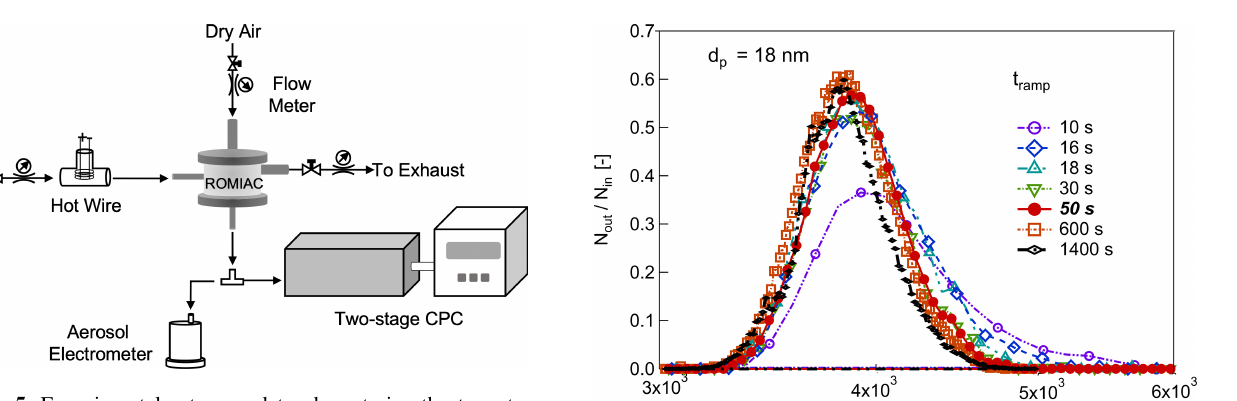
Figure 5. Experimental setup used to characterize the two-stage CPC detection efficiency. A hot-wire aerosol generator was used to provide aerosol samples. The ROMIAC was operated at static mode to provide stable, monodisperse aerosol particles for both the two- stage CPC and the aerosol electrometer. The ROMIAC aerosol and cross-flow rates were Q a = 2 . 5Lmin − 1 and Q x = 35 . 5Lmin − 1 . The electrometer was pre-calibrated against a TSI 3760A butanol- based CPC and an ADI MAGIC™ water-based CPC.